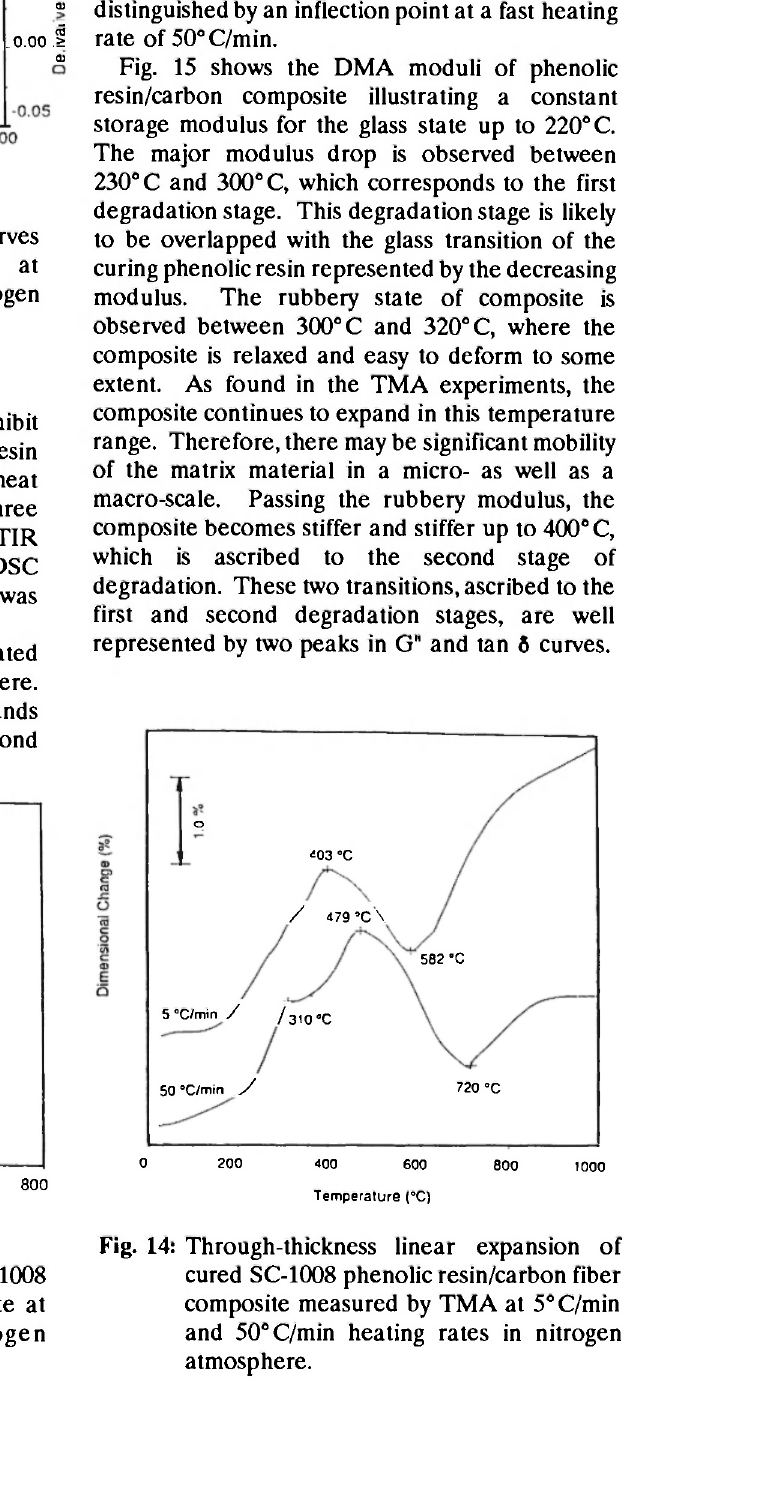
Fig. 14: Through-thickness linear expansion of cured SC-1008 phenolic resin/carbon fiber composite measured by T MA at 5°C/min and 50° C/min heating rates in nitrogen